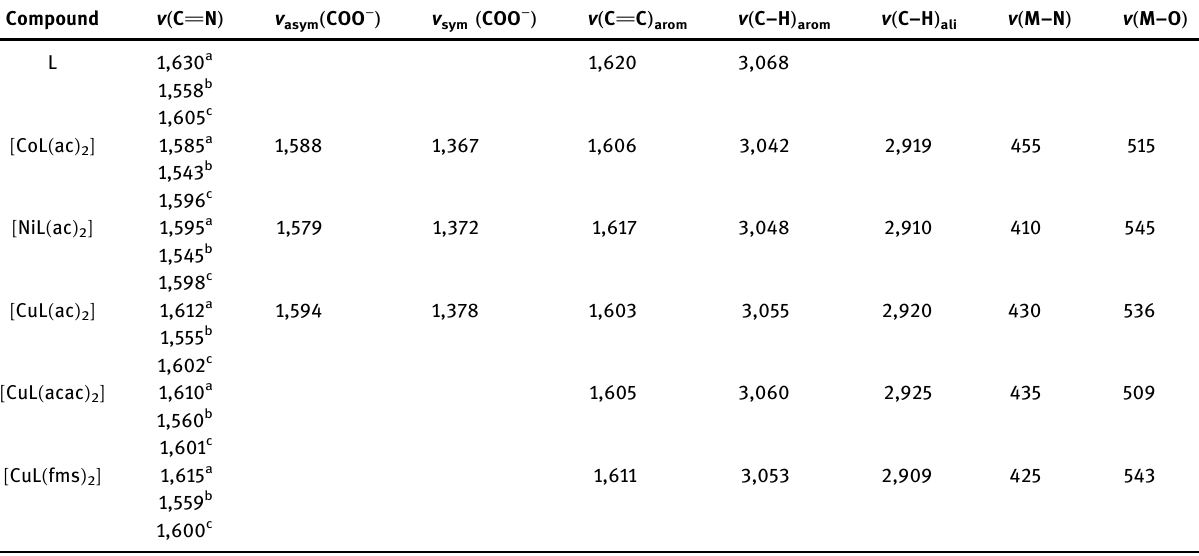
Table 2: Infrared spectral data of the ligand and its complexes. Compound